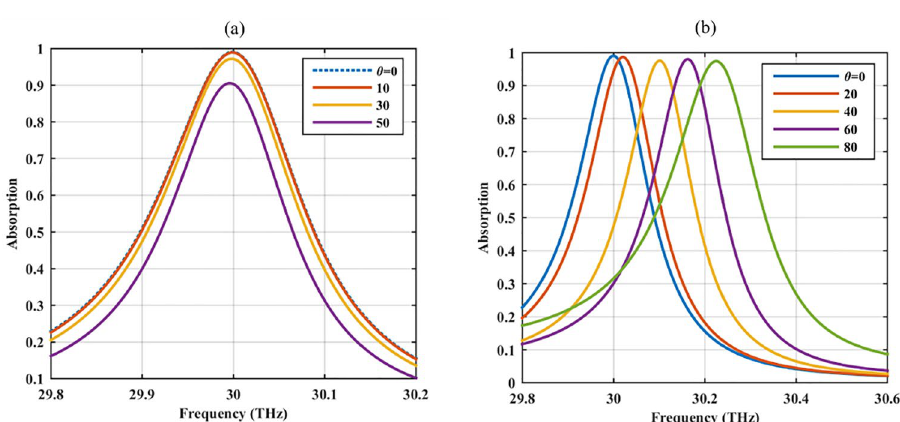
Figure 6. The optical response of the absorber in Fig. 5 for different incident angles ( a ) TE waves and ( b ) TM